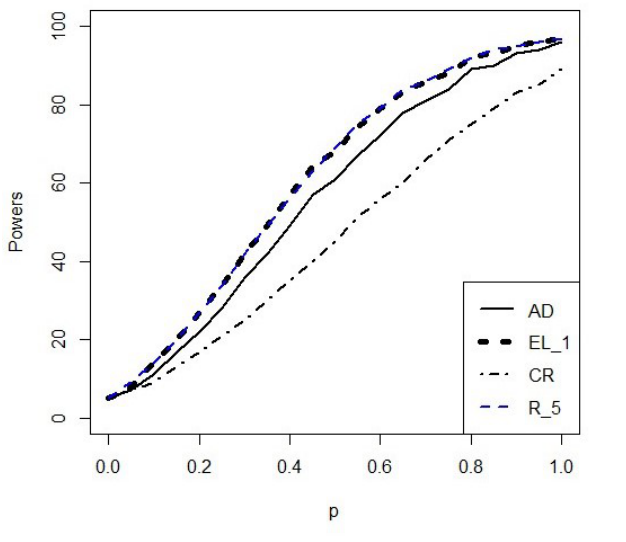
Figure 1. Local powers for some of the tests over the entire range of mixture probabilities of the Rayleigh exponential mixture distribution for n =